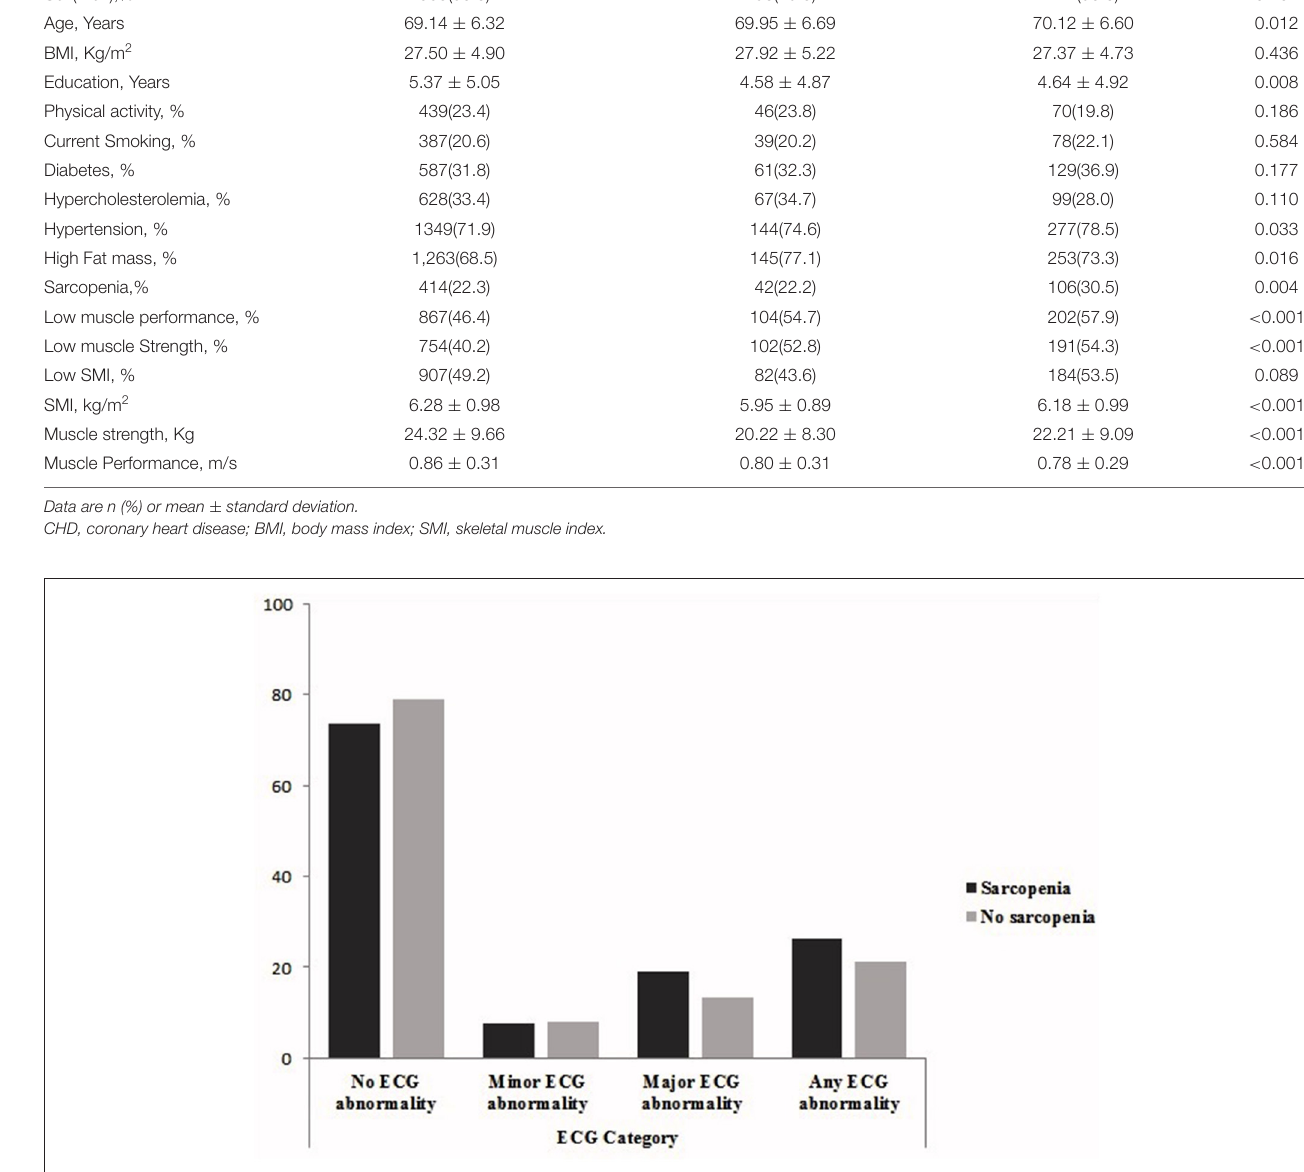
FIGURE 1 | Prevalence rates of sarcopenia according to ECG abnormality